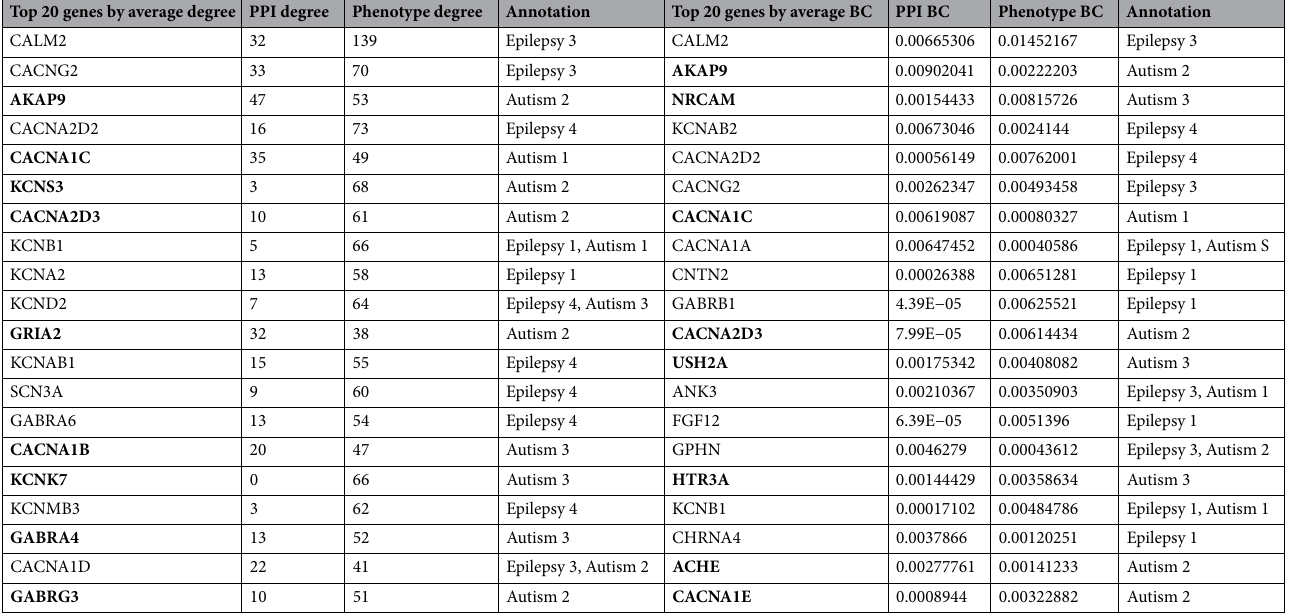
Table 2. Highest centrality genes in module 3. The top 20 genes in module 3 are listed and ranked by average degree and average betweenness centrality (BC). Genes that are autism-specific are bolded since module 3 is an epilepsy-focused module.